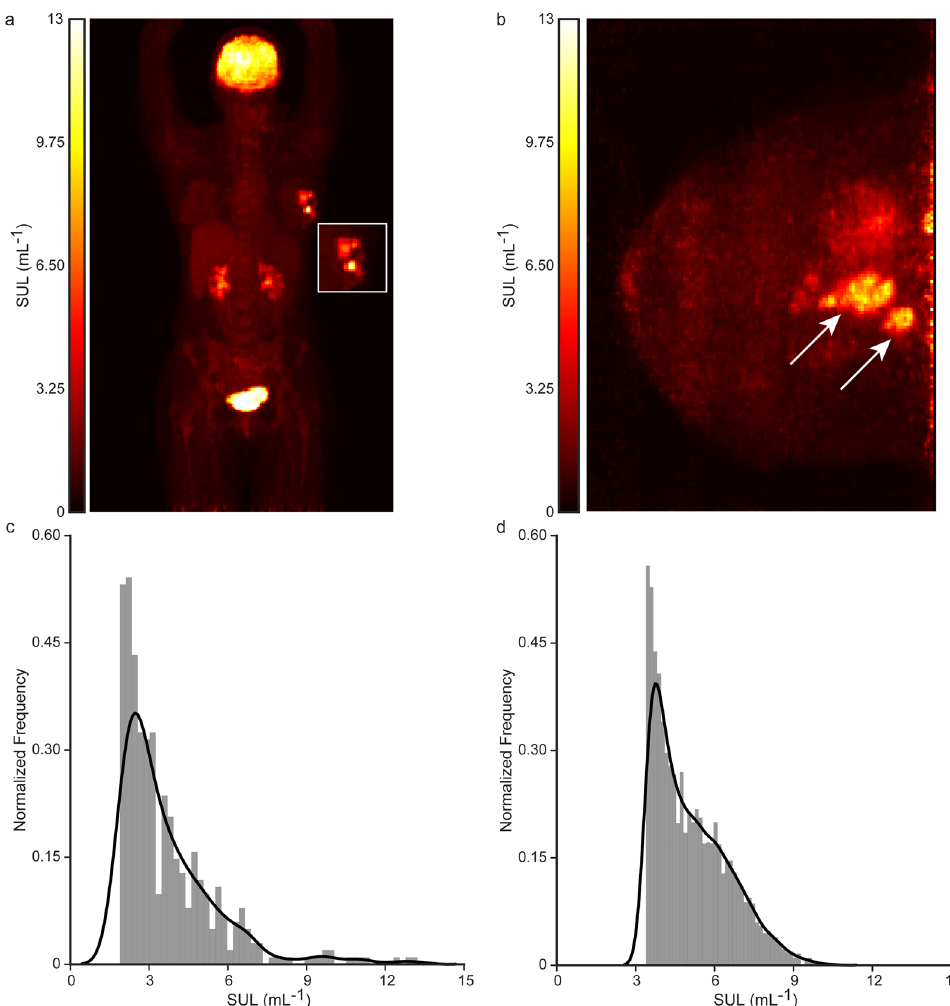
Figure 1. An example of a 39-year-old breast cancer patient with an agglomerate of ER+/PR+/HER2+ tumors imaged by [ 18 F]FDG-wbPET and -dbPET at the pre-treatment timepoint. ( a ) A maximum intensity projection of [ 18 F]FDG-wbPET with primary lesions in the left ipsilateral breast (inset). ( b ) A maximum intensity projection of [ 18 F]FDG-dbPET with corresponding highlighted tumors in the left ipsilateral breast (white arrows). ( c ) Histogram of SULs in the tumor VOI for wbPET. ( d ) Histogram of SULs in the tumor VOI for dbPET. Number of bins in ( c , d ) were restricted to